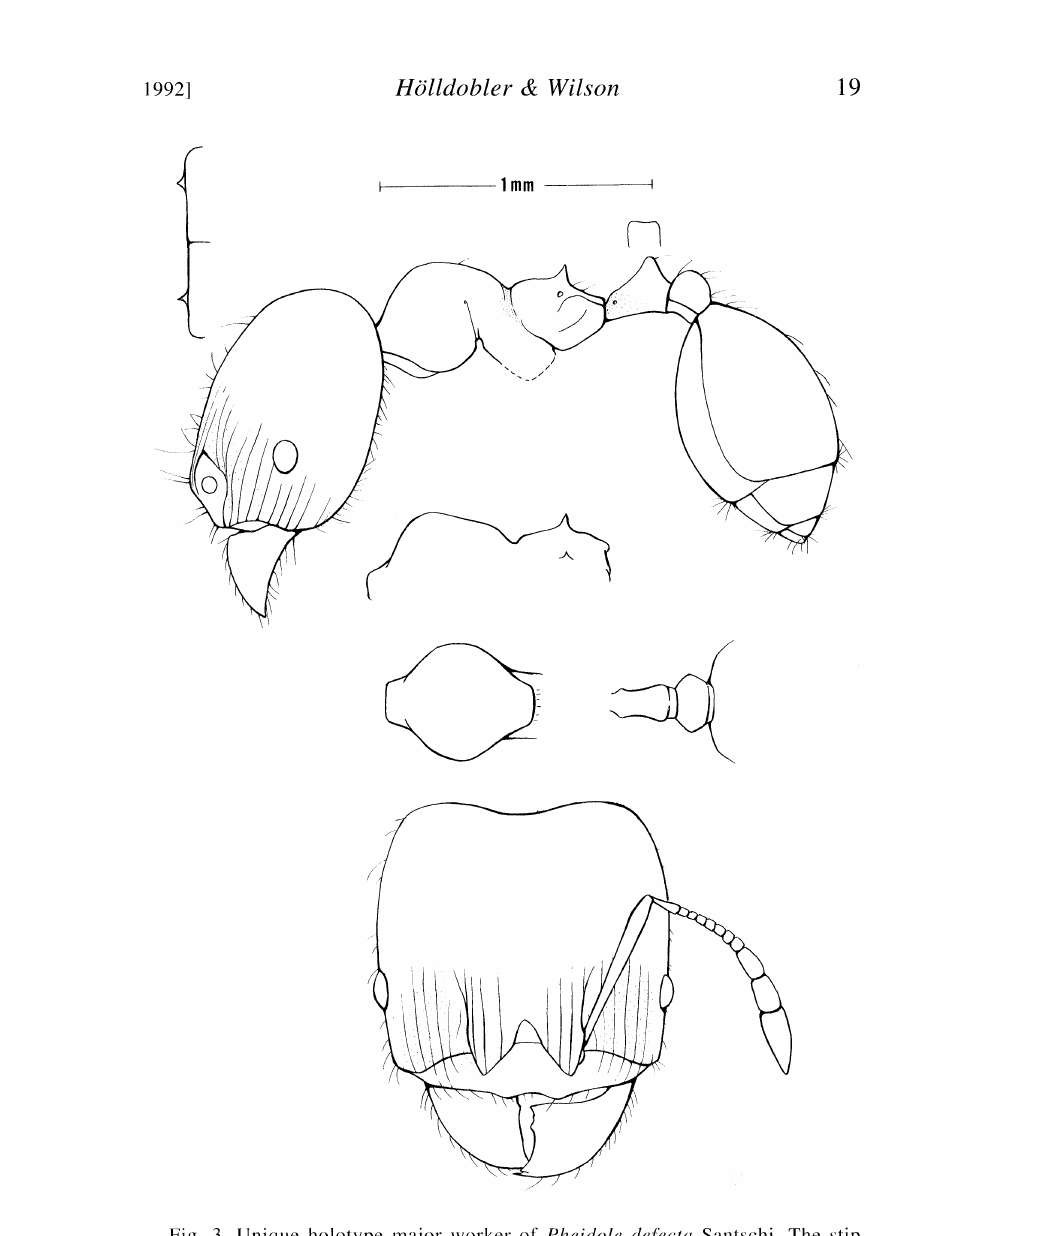
Fig. 3. Unique holotype major worker of Pheidole defecta Santschi. The stip- pling demarcates limited areas of shallow foveolation. The bidentate hypostomal border, similar in appearance to that of P. nasutoides, is depicted in the upper left- hand